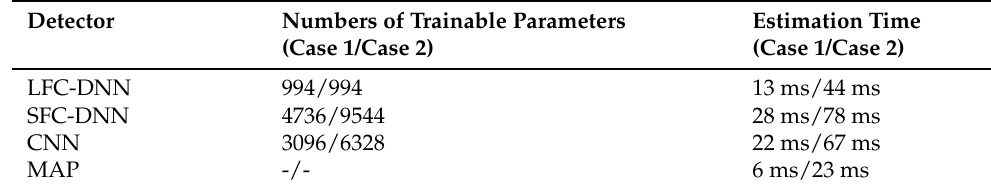
Figure 5. Comparison of BERs for Case 2. Table 2. Comparison of run time of active LED